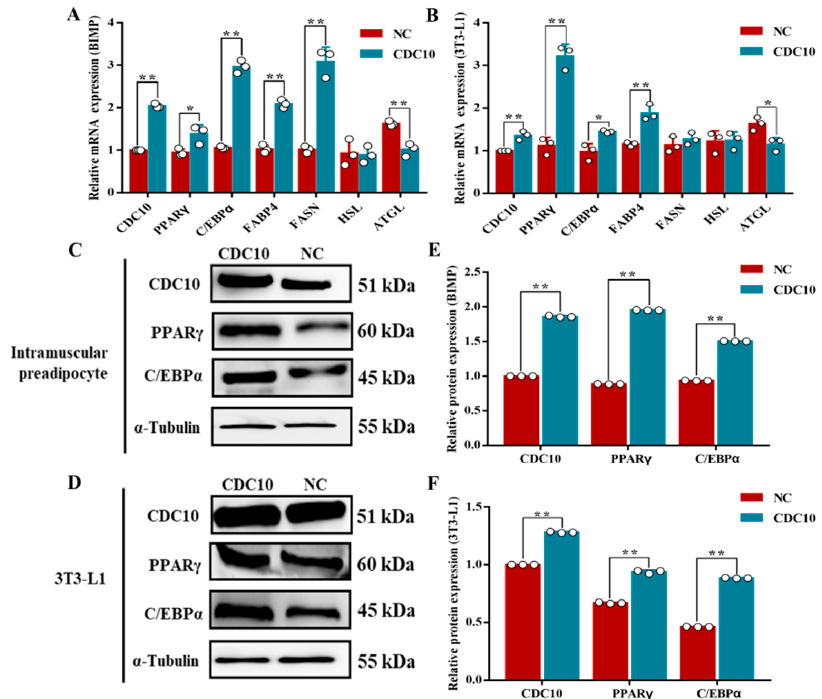
Figure 10. The effect of CDC10 overexpression on the differentiation of bovine intramuscular preadipocyte (BIMP) and 3T3-L1 cells was detected by RT-PCR and Western blot assay. BIMP and 3T3-L1 cells were transfected with lentivirus for 9 d during differentiation. ( A , B ) After over- expression with lentivirus for 9 d, the expression levels of CDC10 , PPAR γ , C / EBP α , FABP4 , FASN , HSL , and ATGL were determined by RT-PCR and normalized to the β -actin level. ( C , D ) Protein levels were assessed by Western blot analysis. ( E , F ) Quantitative analysis of CDC10 , PPAR γ , and C/EBP α proteins in BIMP and 3T3-L1 cells. Values are expressed as mean ± SEM ( n = 3). * p < 0.05, ** p < 0.01. RT-PCR data was normalized to control groups of CDC10